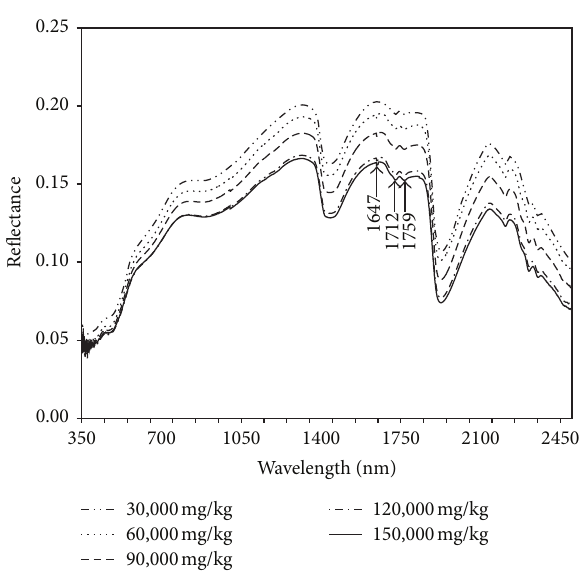
Figure 2: Full-wavelength mean VisNIR spectral reflectance curves of the diesel-contaminated soils.